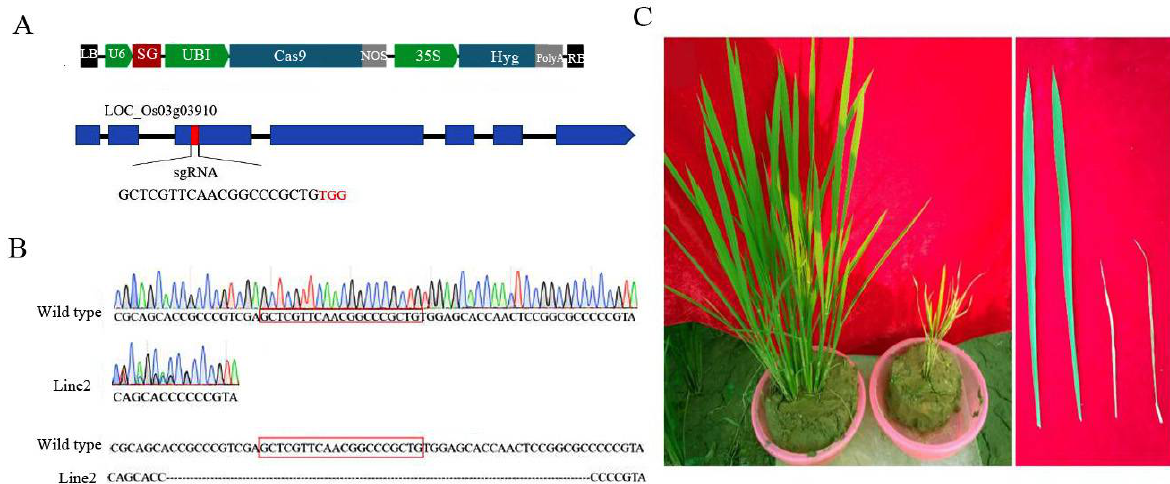
Figure 6. Phenotypes of OsCAT3 crispr transgenic plants. ( A ): Schematic diagram of the OsCAT3 crispr construct. ( B ): Sequence analysis of OsCAT3 crispr transgenic plant. ( C ): Phenotypic analysis of OsCAT3 crispr transgenic plant ( right ) and WT plant ( left ).